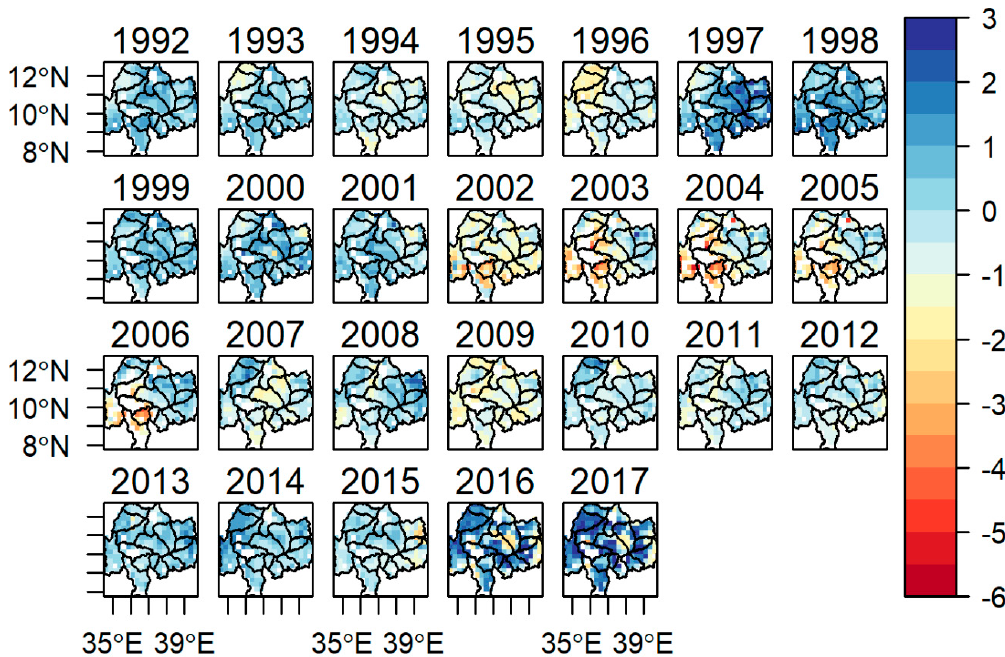
Figure 5. Standard soil moisture anomalies for autumn season in the UBNB indicating the magnitude of departure from long-term mean ASM over a period of 26 years of observation (1992 to 2017). A negative value represents periods drier than normal years, while a positive value indicates wetter than normal soil moisture periods. Table 2. Decadal variability of autumn soil moisture (ASM) across the major land use land cover classes in the UBNB, Ethiopia. A lookup table for the land use land cover classification system is provided